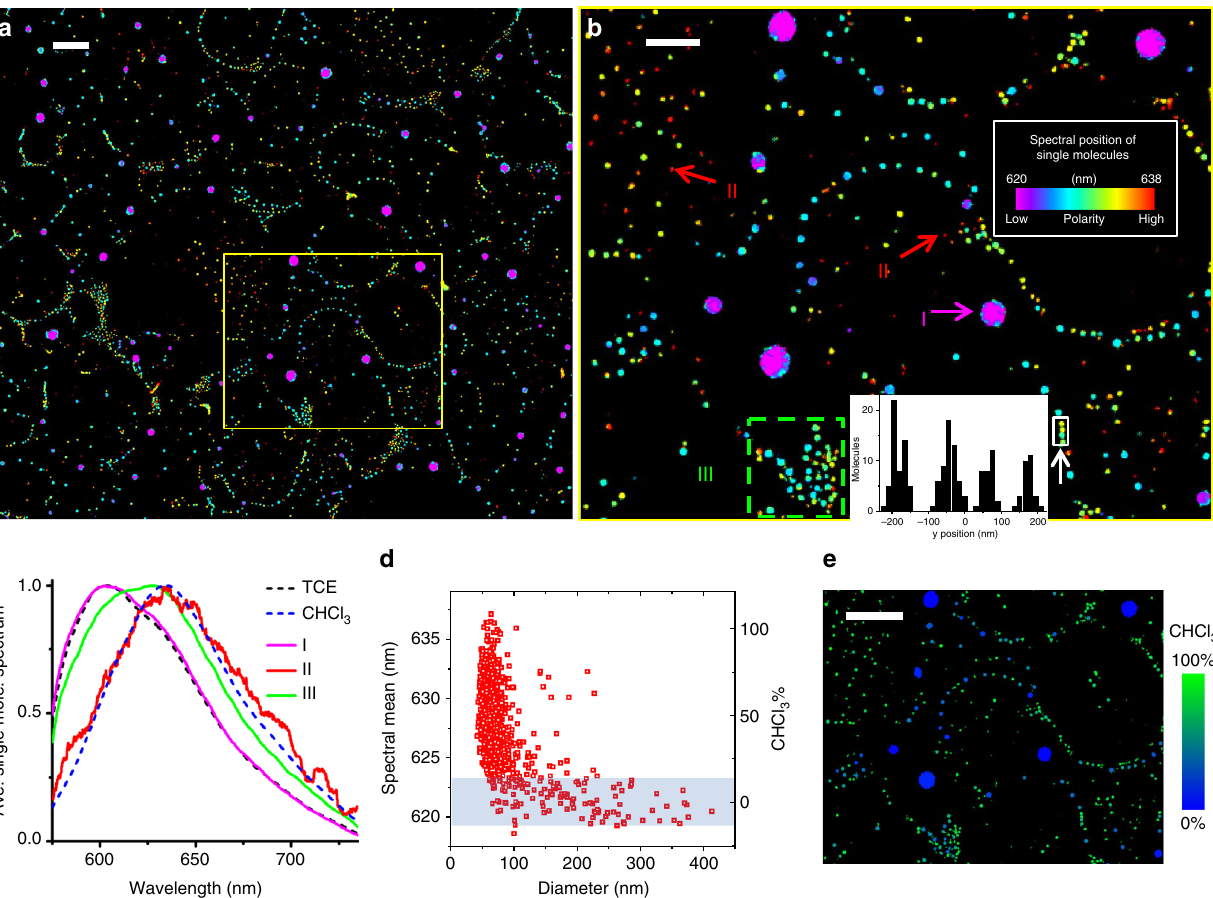
Fig. 4 Nanoscale decomposition of a two-component mixture on the surface. a True-color SR-PAINT image of adlayers from a 1:3 mixture of TCE and chloroform, drawn on a spectral scale of 620 – 638 nm. Scale bar is 2 μ m. b Zoom-in of the yellow-boxed area in a . Inset: intensity pro fi le along the vertical ( y ) direction for the four closely located nanodroplets marked by the white box. Scale bar is 1 μ m. c Averaged single-molecule spectra obtained for Regions I (large nanodroplets), II (the reddest small nanodroplets), and III (small nanodroplets with varying color) in b (solid lines), compared to that of adlayers of pure TCE and chloroform (dash lines). d Averaged spectral mean value (left y -axis) and corresponding chloroform percentage (right y -axis) of each droplet, as a function of droplet size. Shaded band represents the typical range of nanodroplets of pure TCE adlayers. e Recoloring of b by the estimated chloroform percentage of each nanodroplet. Scale bar is 2 μ